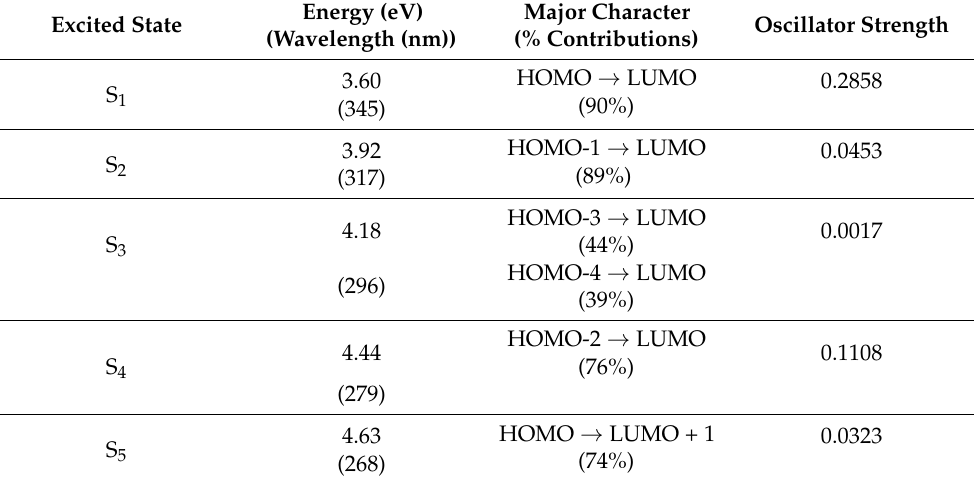
Table 2. Vertical excitation energies, oscillator strengths, and the dominant occupied and virtual orbitals contributing to the five lowest energy singlet excitations of 1b at the level of theory